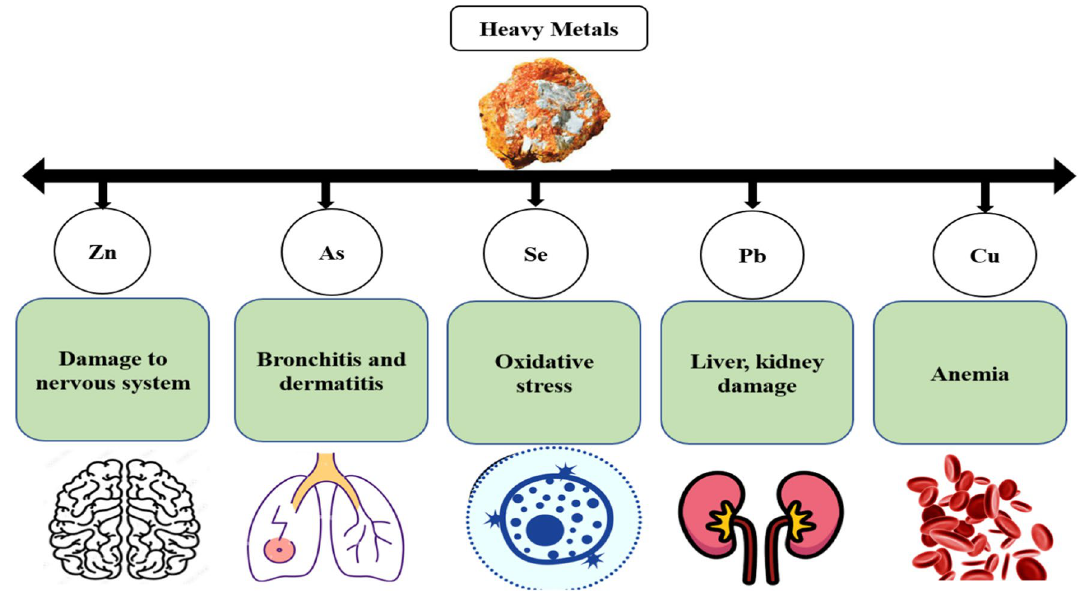
Fig. 4 Health complications due to excessive consumption of HMs via drinking